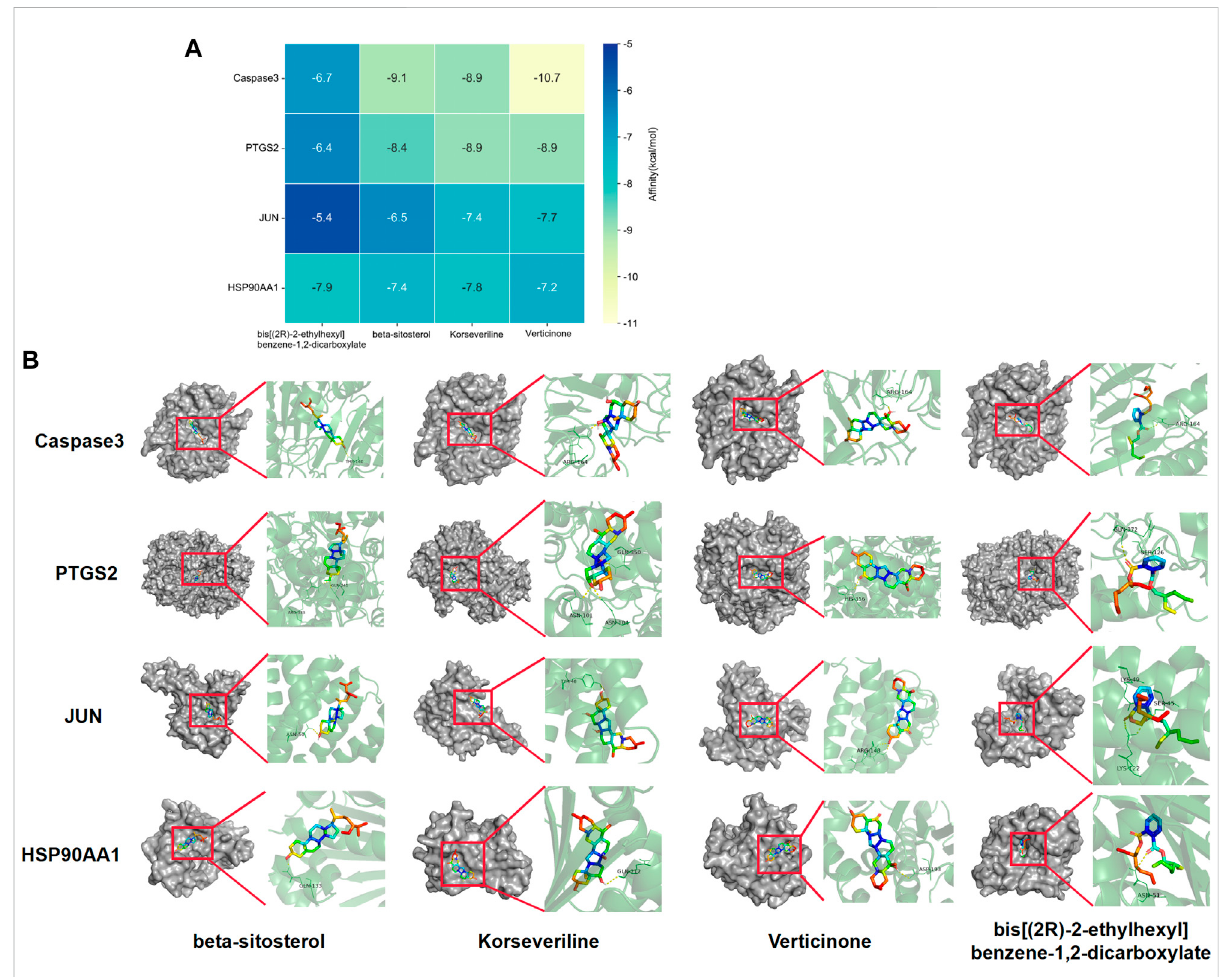
FIGURE 8 Molecular docking between core targets and active ingredients. Heat map of binding energy between four core targets and top four active ingredients by molecular docking (A) . Conformation examples between four core targets and top four active ingredients by molecular docking (B) .